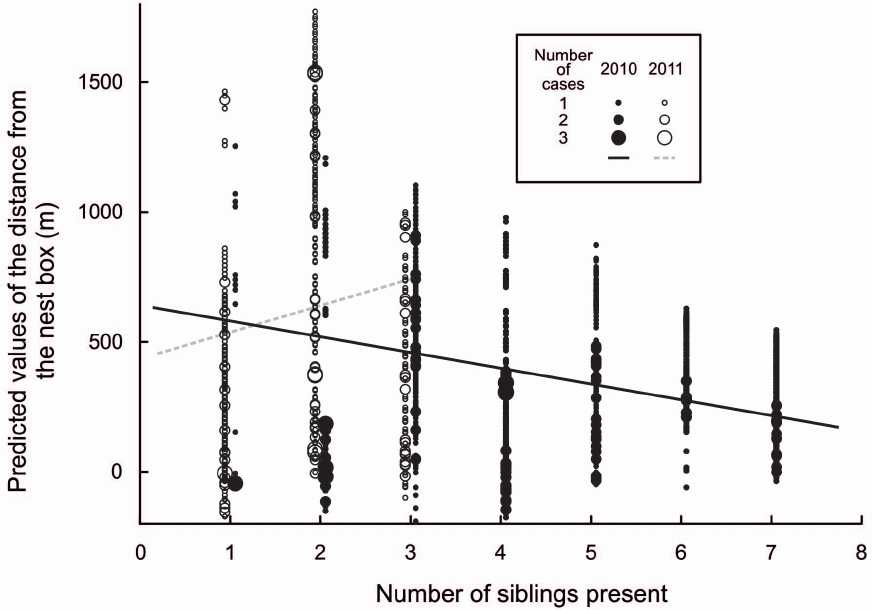
Figure 2. Predicted values of the distance from the nest box for 2010 (filled circles) and 2011 (open circles) plotted against the number of siblings present.